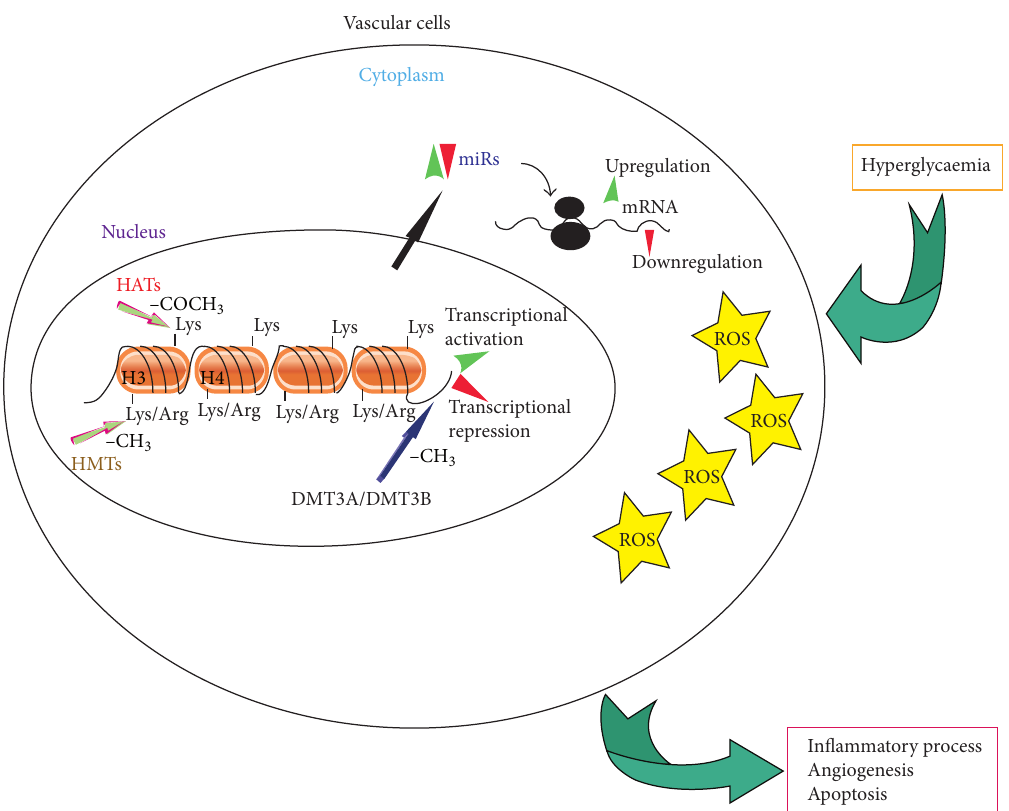
Figure 1: Schematic representation of epigenetic mechanisms in diabetic setting. In the nucleus ROS-mediated histone acetylation/meth- ylation as well as DNA methylation accounts for gene transcriptional activation or repression. In the cytoplasm ROS-mediated changes in miR expression drive posttranscriptional regulation of target genes. Such epigenetic changes impact long-term diabetes-associated complications. HTAs: histone acetyltransferases; HMTs: histone methyltransferases; DMT: DNA methyltransferase; ROS: reactive oxygen species;